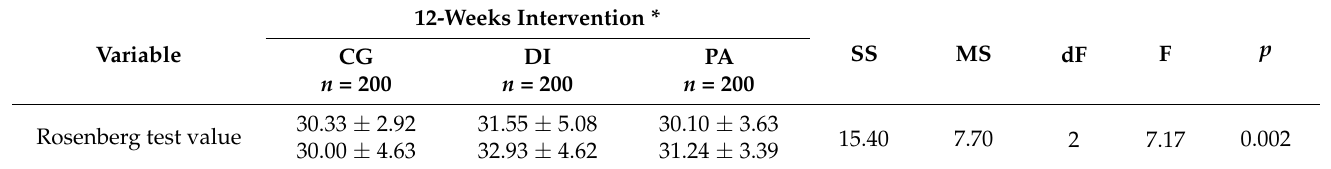
Table 3. Global self-assessment scores—differences between groups (Rosenberg scale)— n =